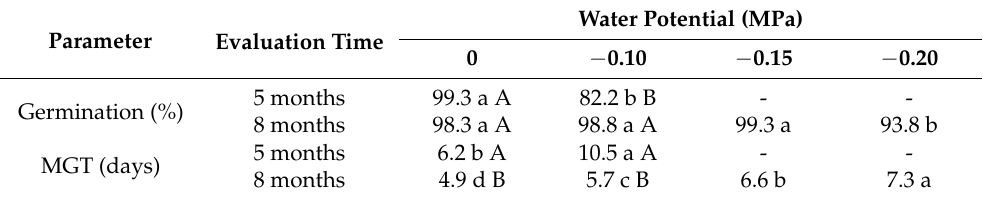
Table 2. Germination percentage and mean germination time (MGT) of tomato seeds from all nitrogen fertilization treatments, evaluated for different water potential solutions and times (5 or 8 months after harvest). Different letters represent significant differences according to Tukey test ( p = 0.05). Lowercase letters represent differences between water potentials for each evaluation time. Capital letters represent differences between evaluation times for each water